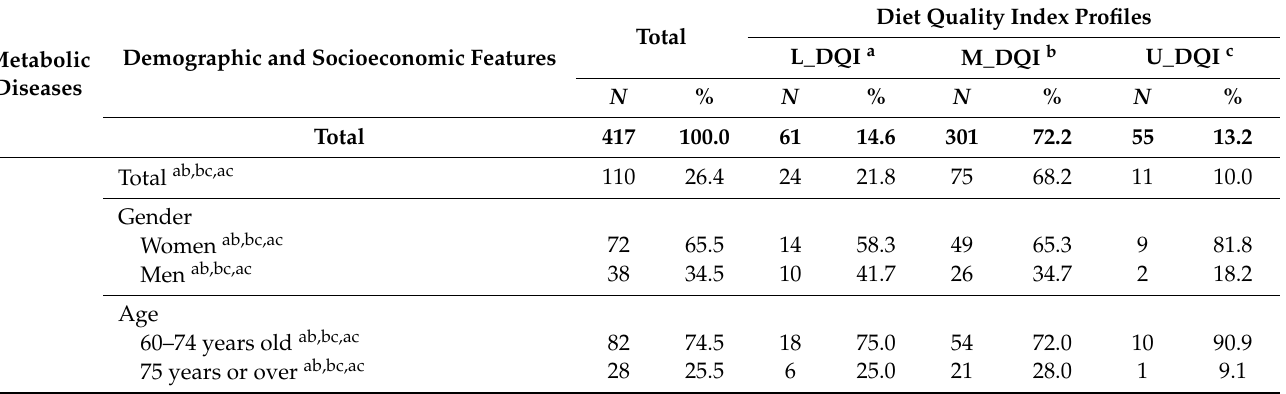
Table 3. Differentiation of diet quality according to the presence of declared metabolic diseases, selected demographic characteristics and socioeconomic